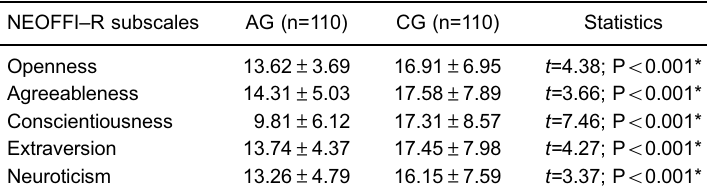
Table 2. Personality scores in the alcoholic (AG) and control group (CG), and group comparison statistics on the Five Factors Inventory NEO Revised – Pocket (NEOFFI-R) version